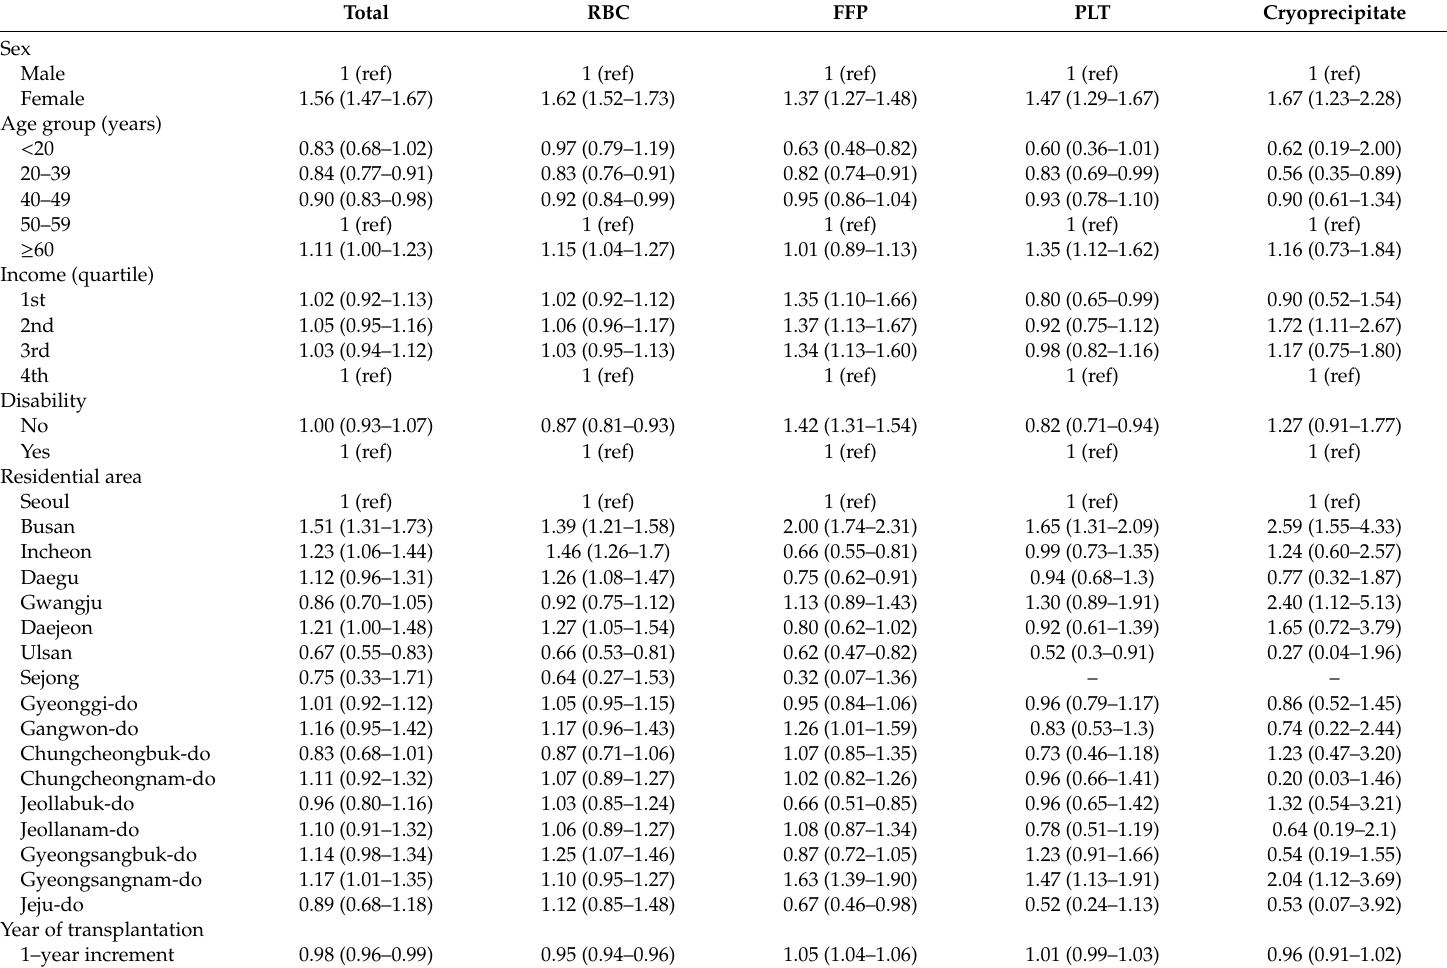
Table 3. Factors associated with transfusion among kidney